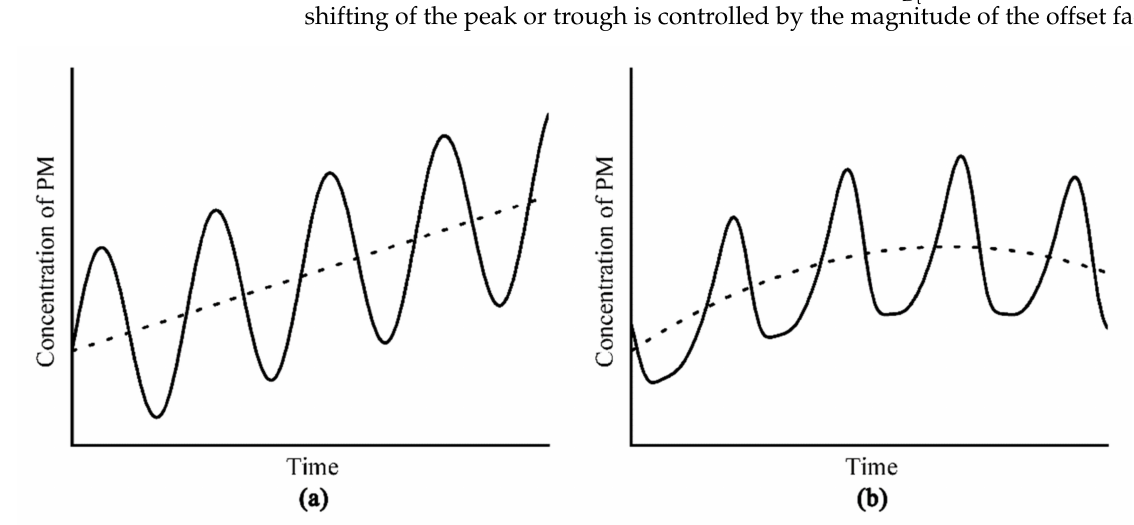
Figure 1. Schematic diagram of the traditional ( a ) and improved ( b ) sine function models.